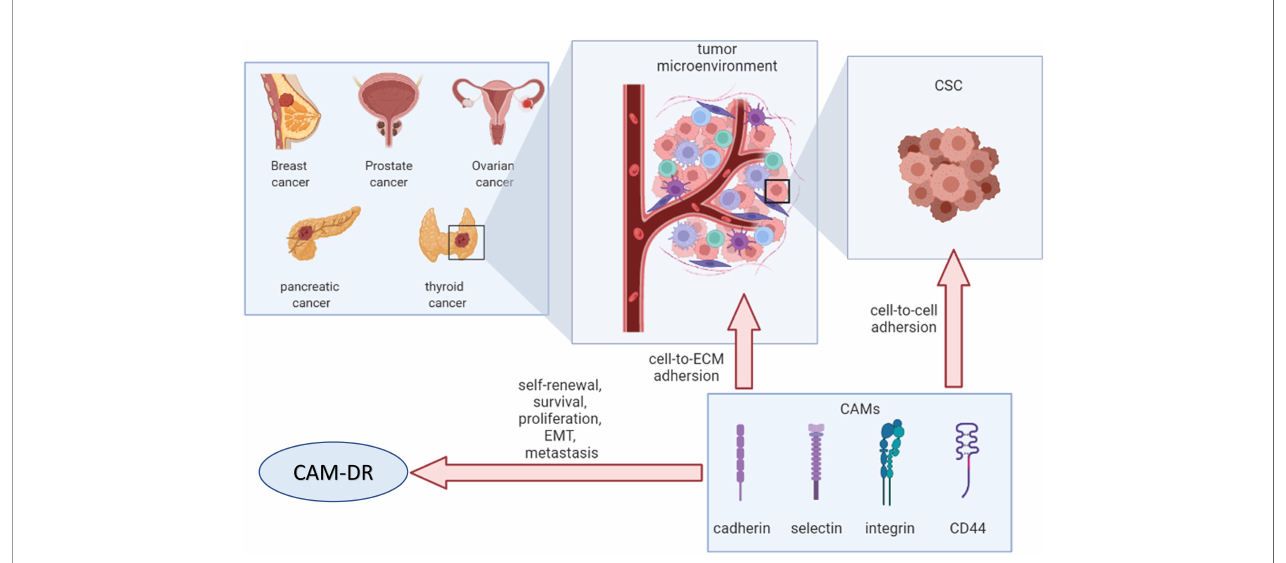
FIGURE 6 | Overview of cell adhesion molecules in endocrine-related cancers. CSC, cancer stem cell; ECM, extracellular matrix; CAMs, cell adhesion molecules; EMT, epithelial – mesenchymal transition; CAM-DR, cell adhesion-mediated drug